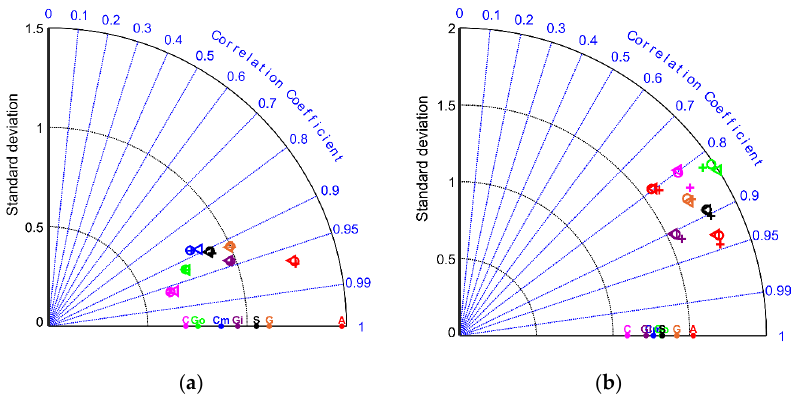
Figure 7. Taylor diagrams for the case studies in Table 3. Results are relative to Hs ( a ) and Tm ( b ) are reported. The plus (+), circle ( ◯ ) and triangle ( ⧍ ) symbols refer to the N scheme, PSI scheme and FCT scheme, respectively. Each buoy is represented by a different color: Alghero (A) in red, Capo Mele (Cm) in blue, Castiglione (C) in pink, Giannutri (Gi) in purple, Gombo (Go) in green, Gorgona (G) in orange and La Spezia (letter S) in black. In the third calibration phase, three different physical parameterizations were com- pared: ST2 [70], ST3 [71] and ST4 [56], leaving the 60 s time step and the N scheme un- changed. For the ST3 parameterization, the STAB3 switch was activated to take into ac- count a stronger gustiness in unstable atmospheric conditions [45]. Statistical indicators